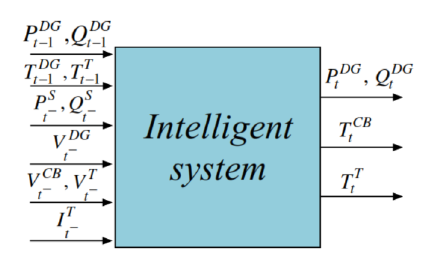
Figure 4. Input and output variables of the proposed